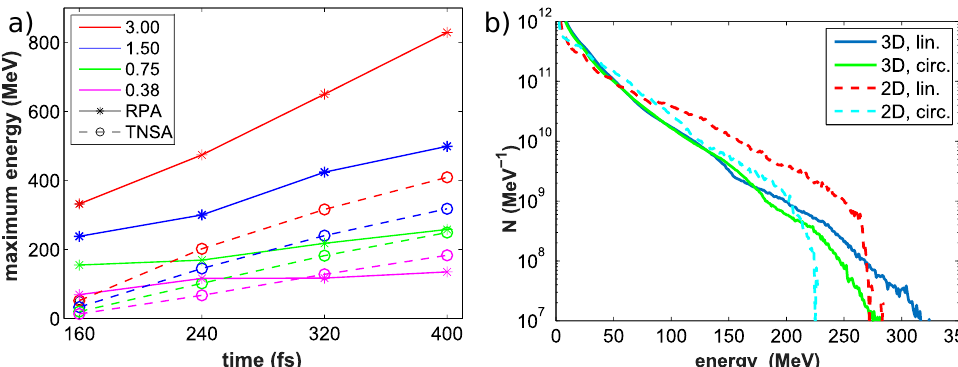
Figure 4. Maximal proton energy and ion spectra from hydrogen target. ( a ) Temporal evolution of maximum energies of protons accelerated by the RPA and TNSA mechanisms for various laser intensities. ( b ) Proton energy spectra for linearly and circularly polarized laser beams in 2D and 3D simulations at 260 fs from the beginning of the laser pulse interaction. Target thickness is reduced to 15 µ m and pulse duration to 200 fs. Peak intensity I = 1.5 × 10 22 W/cm 2 . Republished with permission of IOP Publishing, Ltd., from [23], permission conveyed through Copyright Clearance Center,